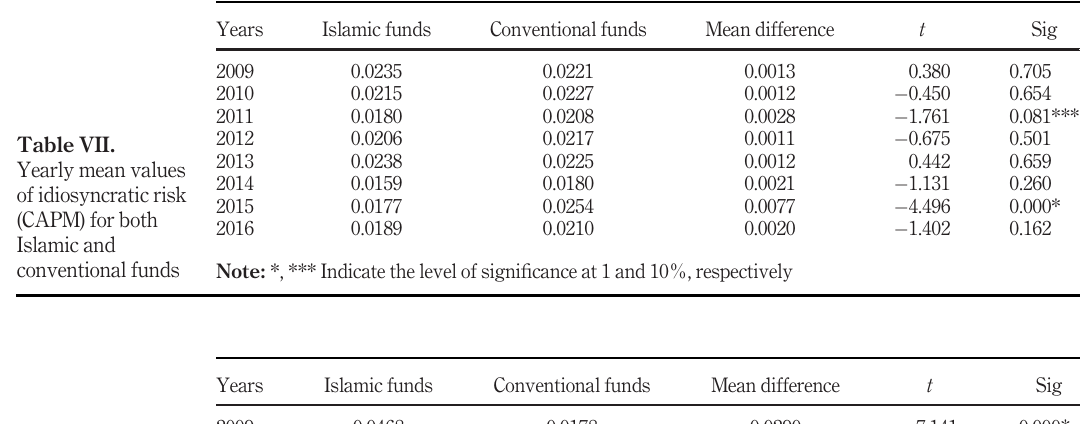
Table VIII. Yearly mean values of idiosyncratic risk (three factors) for both Islamic